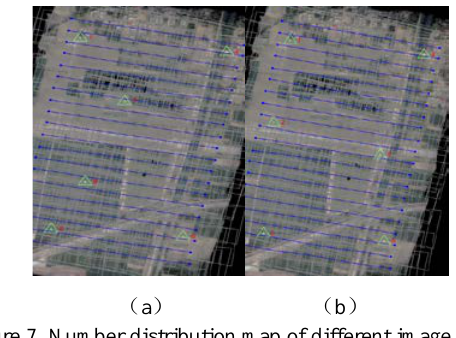
Figure 7. Number distribution map of different image control points in the same survey area